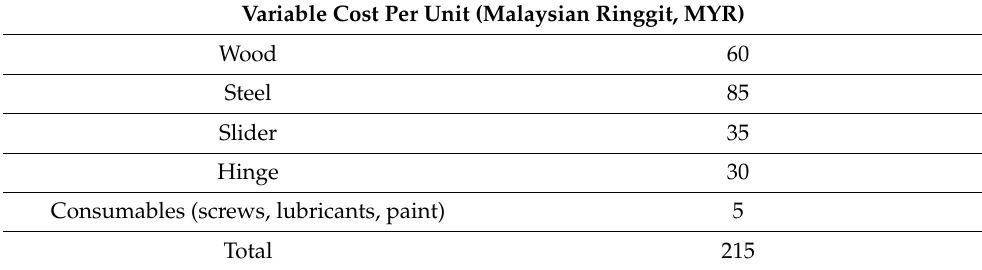
Table 19. Material cost per unit (case 2).